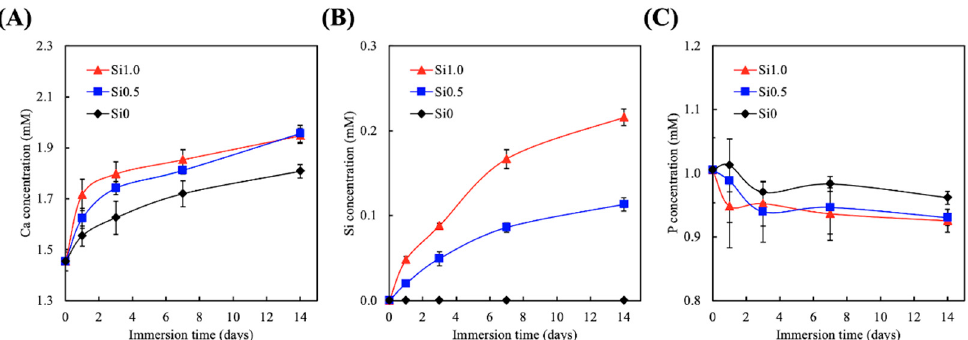
Figure 4. ( A ) Ca, ( B ) Si, and ( C ) P ions release analysis of hydrogels after immersion in simulated body fluid (SBF) for 14 days.